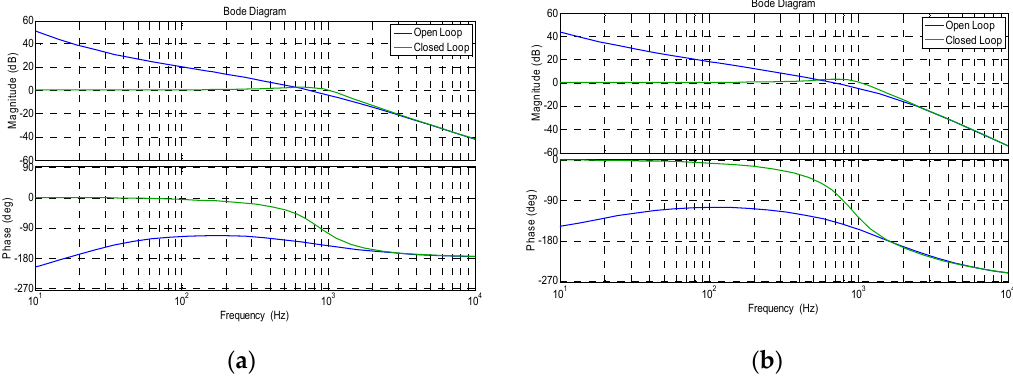
Figure 6. Bode diagrams of the closed-loop control systems: ( a ) Single closed-loop control system, ( b ) double closed-loop control system.